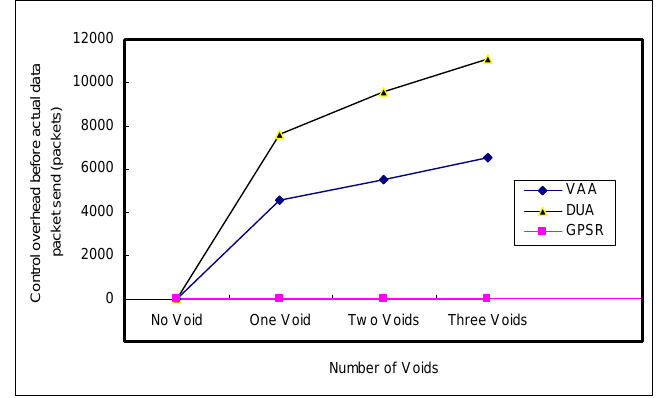
Figure 21. Control overhead (generated by routing) before sending data